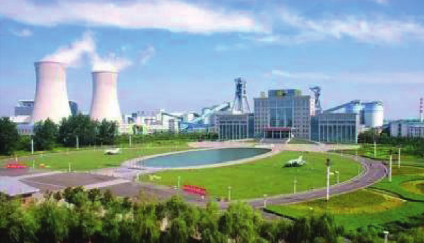
Figure 2: Industrial square of Dingji coal mine. Table 1: Geothermal data of partial boreholes.